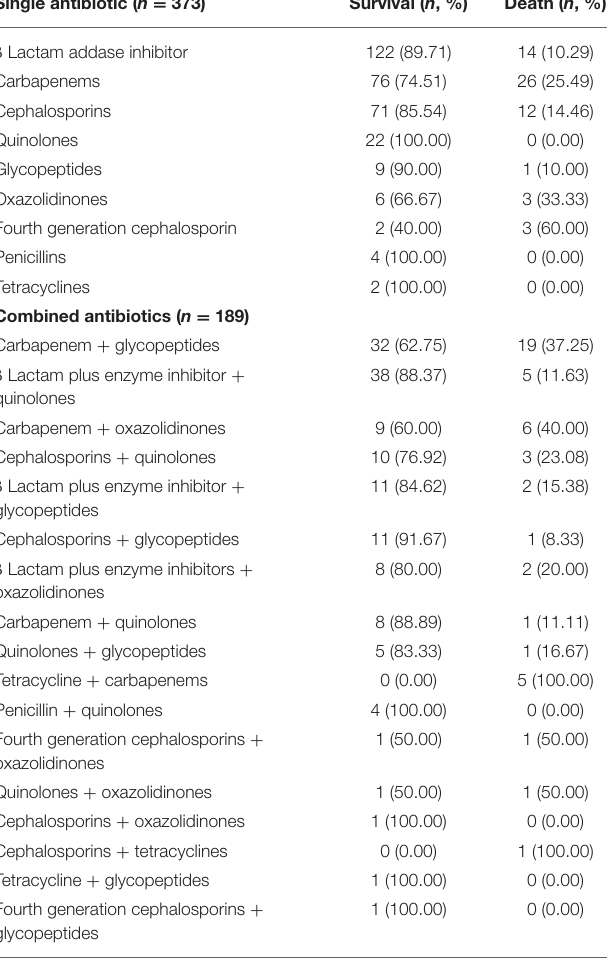
TABLE 3 | Mortality of patients with bloodstream infection treated with different antibiotics. Single antibiotic ( n = 373) Survival ( n , %)